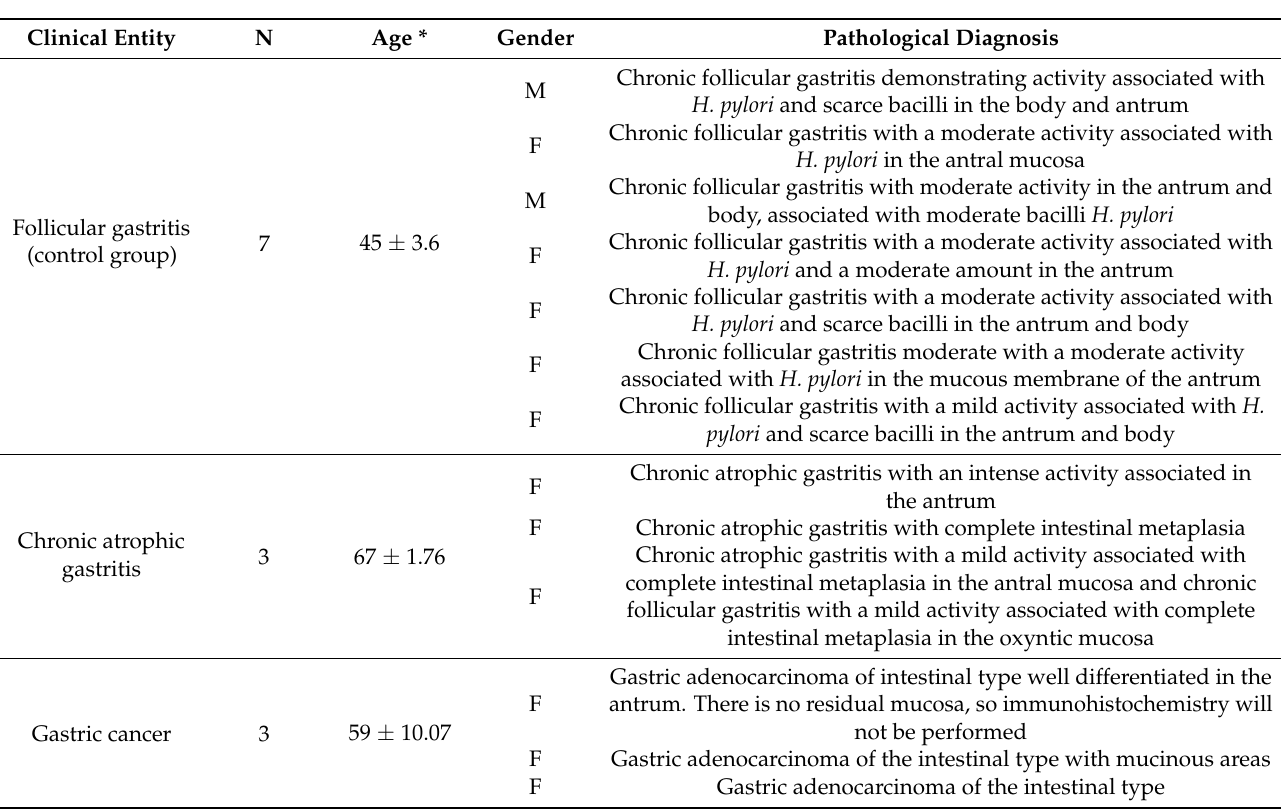
Table 1. Clinical characteristics of